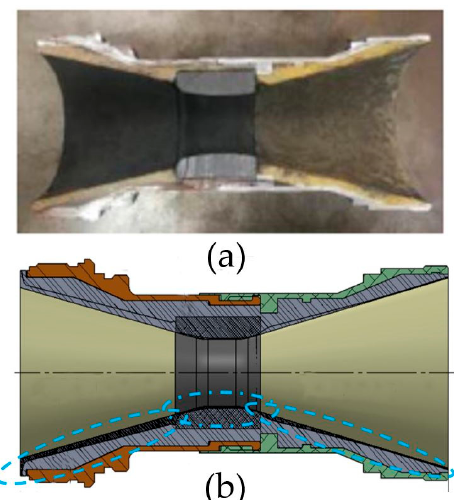
Figure 17. The ablation in nozzle from the static experiment: ( a ) an actual image and ( b ) sketch image.